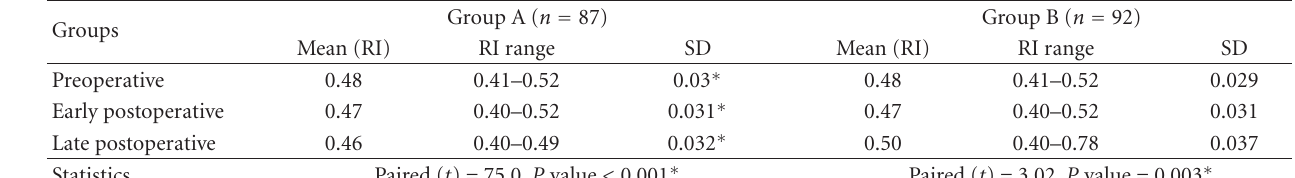
Table 5: Duplex evaluation of centripetal artery in males of both